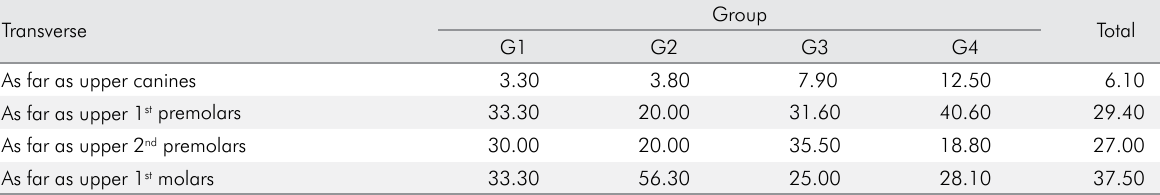
Table 6. Percentages of the transverse smile by group. p =0.004 (significant).